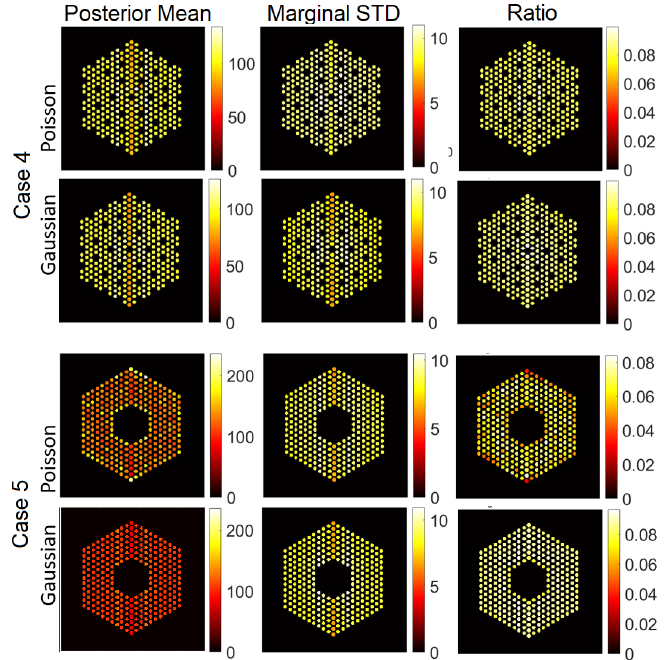
Figure 13. The IDEAL response matrix: Pin pixels averaging of the proposed approach for Case “4” and Case “5”. ( Left-hand column ): posterior mean, ( middle column ): marginal standard deviation, and ( right-hand column ): the ratio of marginal standard deviation divided by posterior mean.